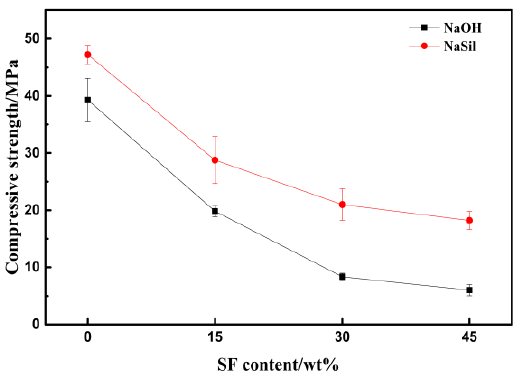
Figure 4. Compressive strength of geopolymers function of SF content.